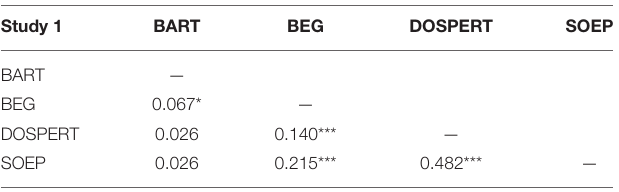
TABLE 2 | Correlation analysis—Pearson correlation coefficients for the main risk measures for study